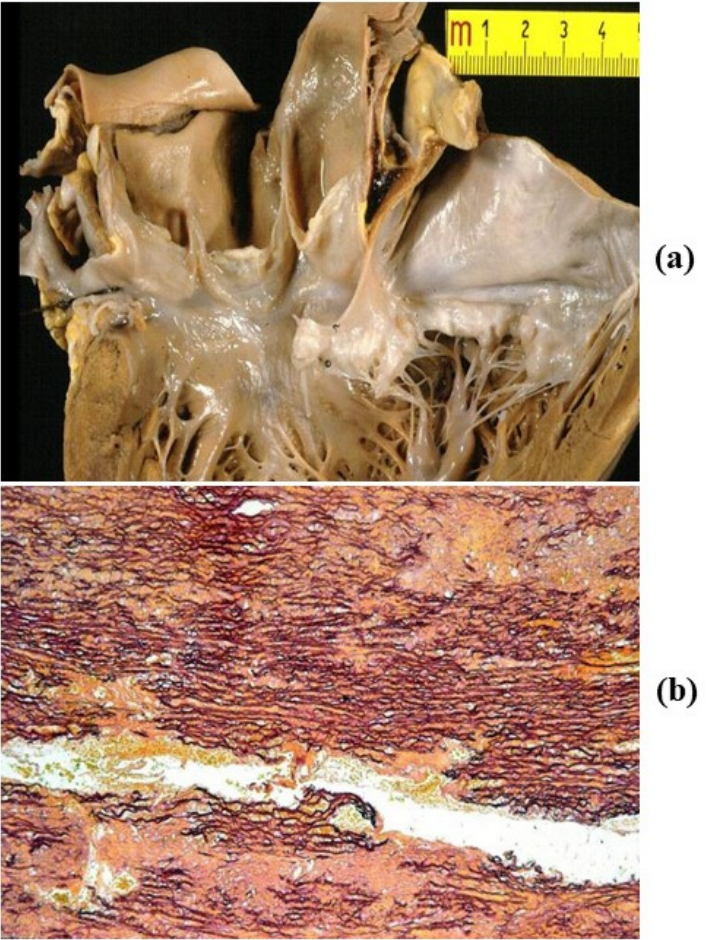
Figure 10. Aortic dissection in Marfan syndrome and sudden death. ( a ) Gross view: intimal tear in the tubular ascending aorta and mitral valve prolapse. ( b ) Histology of the aortic wall: severe elastic fibers frequent in aortic dissection. (Weigert Van Gieson stain).